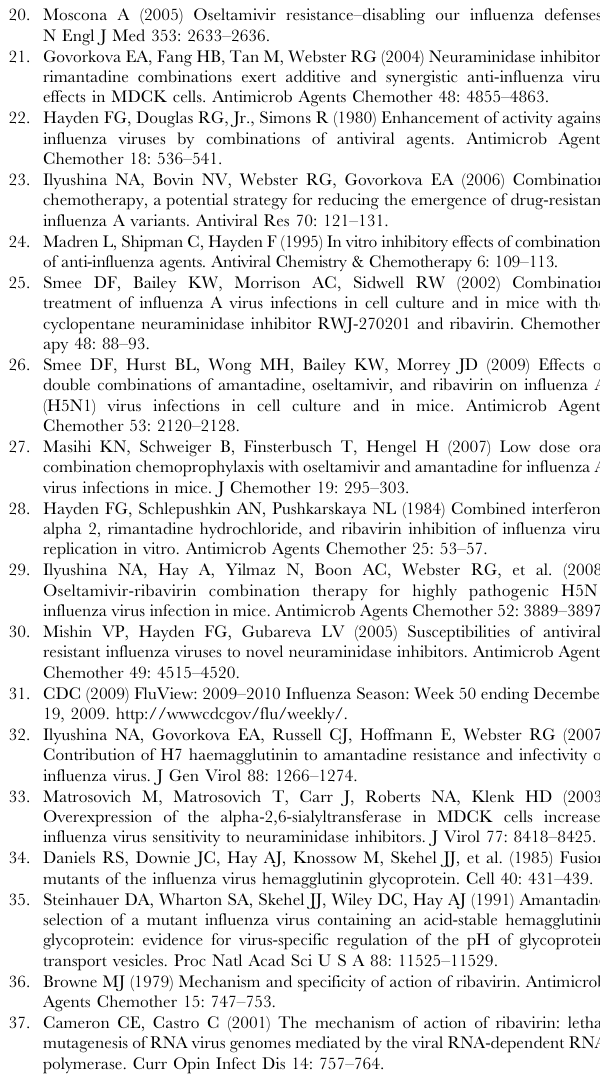
experiments (3.2 m g/mL amantadine, 10 m g/mL ribavirin, and determined by Neutral Red assay after 72 hours. Values are the mean of nine replicates from three experiments, with standard deviations. The difference in viability between the TCAD treated cells and the cell controls was not statistically significant (P